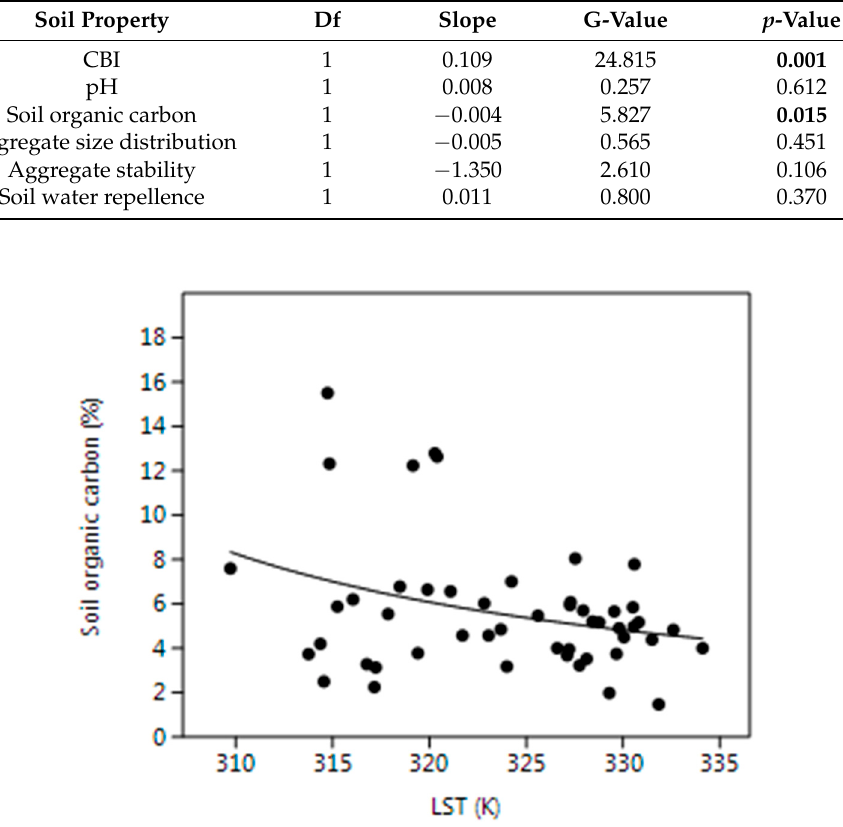
Figure 4. Relationship between LST values (K) and soil organic carbon content